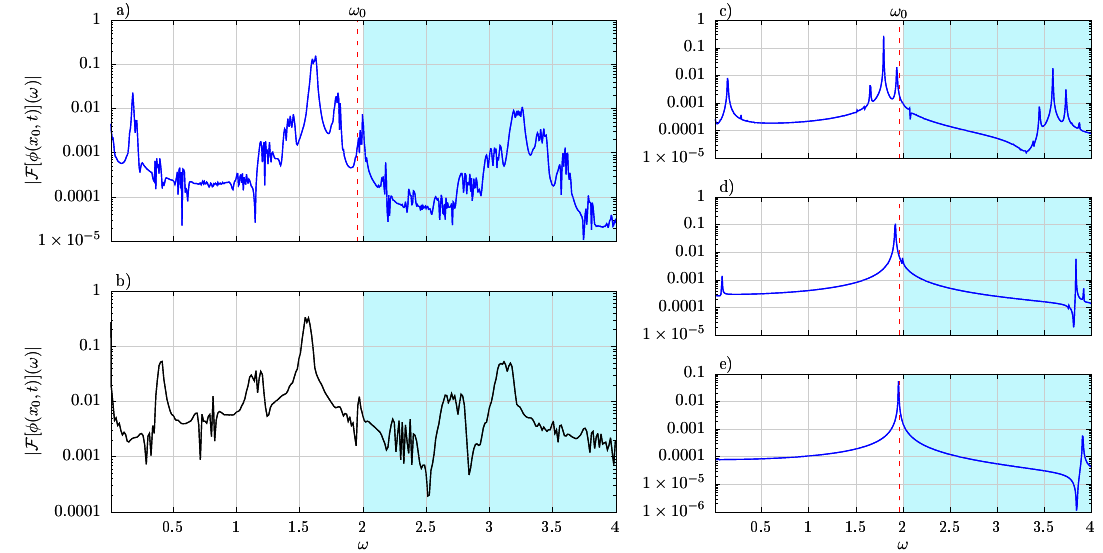
Figure 25 . (a) Power spectrum of the (cid:12)eld after the collision (cid:22) K + K 0 for (cid:11) = (cid:0) 0 : 1, v = 0 : 2 measured at x = x 0 = (cid:0) 2 compared with (b) the power spectrum of the oscillon (cid:11) = 0 and (c-e) in the damped evolution with increasing damping